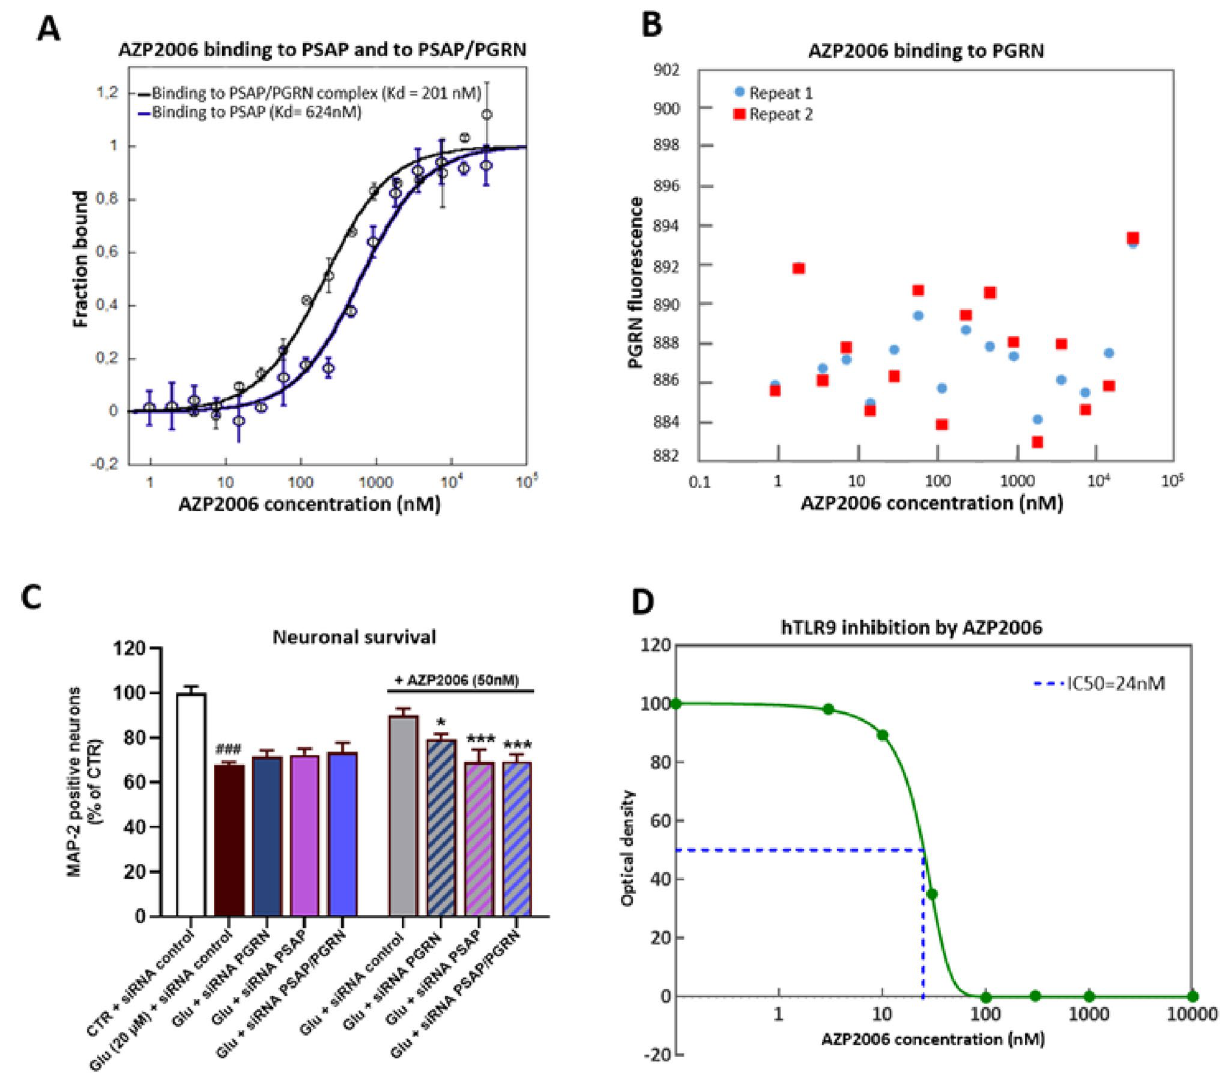
Figure 3. MST analysis of the interactions between AZP2006, PGRN and PSAP. ( A , B ) The compound AZP2006 was added in increasing concentrations to the two RED-labeled peptides (PGRN and PSAP) that served as targets. Raw fluorescence data were normalized to the fraction of bound target. Error bars represent standard deviations from two individual repeat measurements. The Kd was determined from curve fitting according to the Hill equation 77 . ( C ) The positive effect of AZP2006 on rat cortical neurons survival is totally abolished by PGRN and PSAP knockdown (24 h of siRNA transfection). CTR + siRNA control = 54.17 positive soma, ± 1.49, n = 6. All values are expressed as mean ± SEM (standard error of the mean). One-way ANOVA followed by PLSD Fisher’s test, n = 5–6. # p < 0.05 versus CTR + siRNA control ; * p < 0.05 versus Glu (20 µM) + siRNA control. ( D ) dose/response analysis for AZP2006 on hTLR9 activity. All tested doses of ALZ2066 (3, 10, 30, 100, 300 and 1000 nM) were able to diminish hTLR9 activity up to totally antagonize its function at 100 nM (IC50 = 24